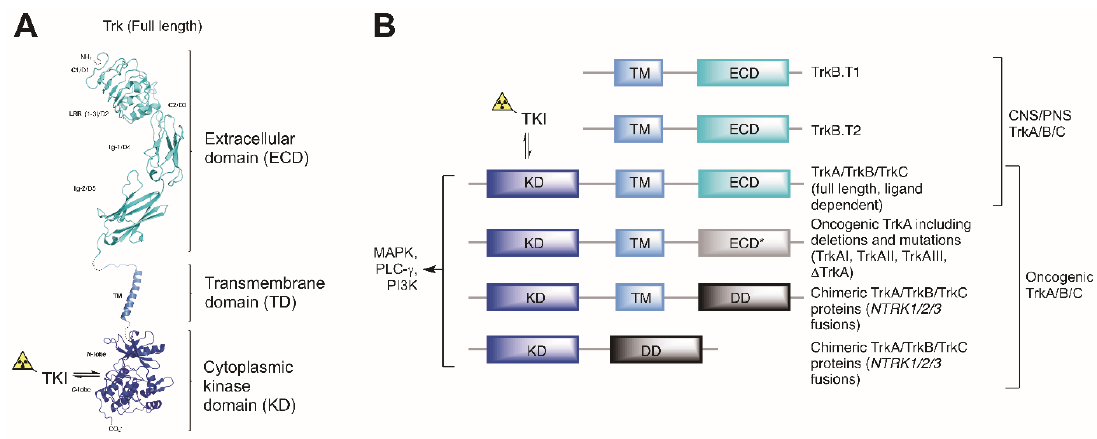
Figure 1. Detailed and representative domains of normally expressed and aberrantly expressed oncogenic tropomyosin receptor kinase (Trk) proteins from NTRK fusions (TKI: tyrosine kinase inhibitor). ( A ) Structure overview of the representative full TrkA receptor (D1 – D5: domain 1 – 5; C1/3: cysteine cluster 1/3; LRR: leucine-rich repeat; Ig-1/2: immunoglobulin domain 1/2, TM: transmembrane domain). ( B ) Schematic representation of diverse Trk proteins and domains, including Trk splice variants and Trk fusion proteins. Dimerization and trans-autophosphorylation of Trk kinase domains leads to the activation of the downstream signaling pathways, including MAPK1, PI3-K/Akt and PLC- γ1 (DD: dimerization domain).